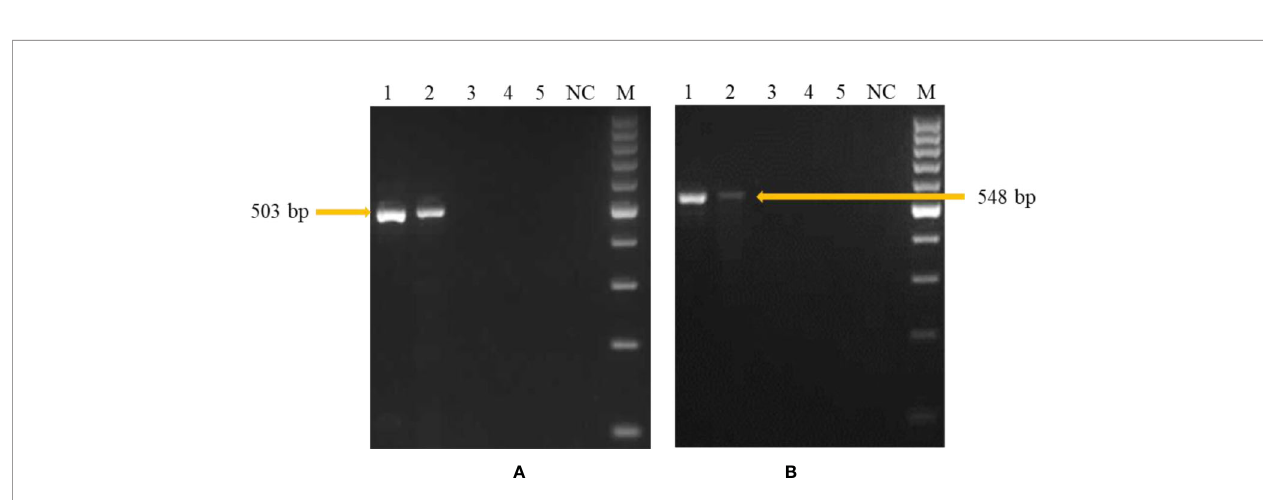
FIGURE 4 | Polymerase chain reaction (PCR) based sensitivity test of the UA-17F/UA-519R (A) and UA-15F/UA-562R (B) marker with different amounts of DNA template of U. agropyri FLS1. M: Marker; Lanes 1 – 5 indicate 10 ng, 1 ng, 100 pg, 10 pg, and 0.1 pg U. agropyri FLS1 DNA, respectively; NC: Negative control without DNA